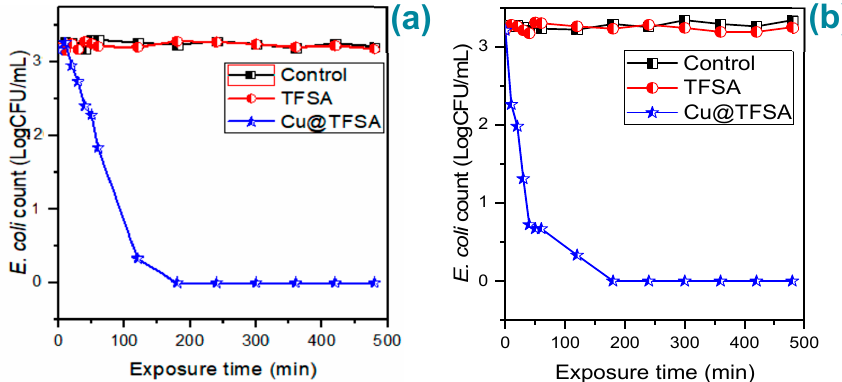
Figure 6. The effect of exposure time on E. coli by Cu@TFSA in river water ( a ) and ( b ) the effect of exposure time on E. coli by Cu@TFSA in